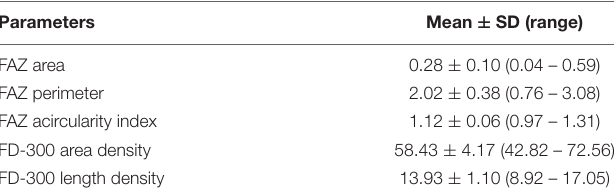
TABLE 5 | The corrected parameters of FAZ and FD-300 of normal eyes in children with 6 mm × 6-mm scan pattern [Mean ± standard deviation